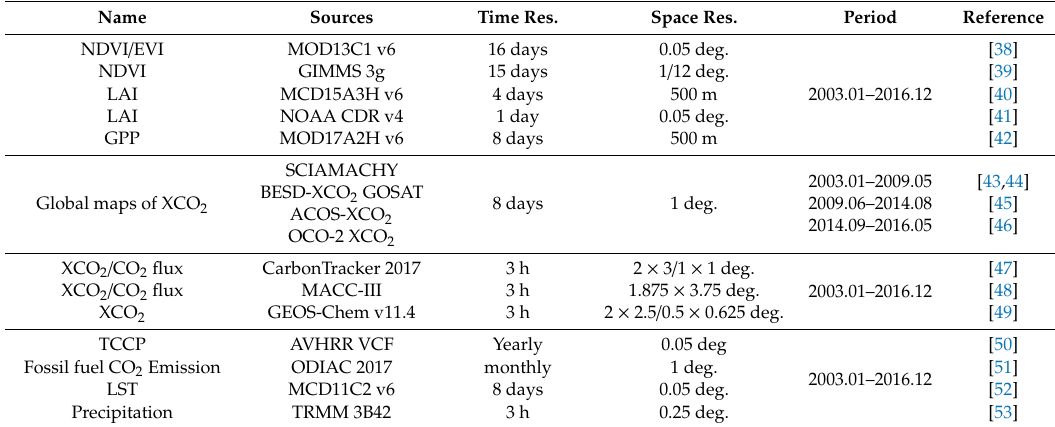
Table 1. Datasets used in this